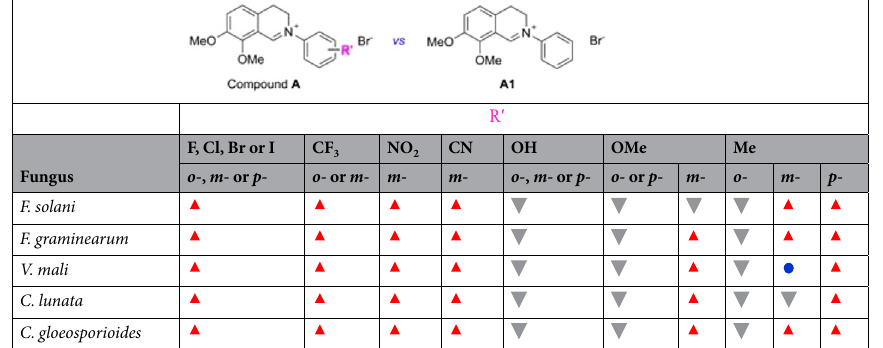
Table 4. Effects of the substituents (R ′ ) on C-ring on the activity of compounds A. Significantly increasing the activity relative to compound A1 (R ′ = H); Significantly decreasing the activity; No significant effect on the activity.